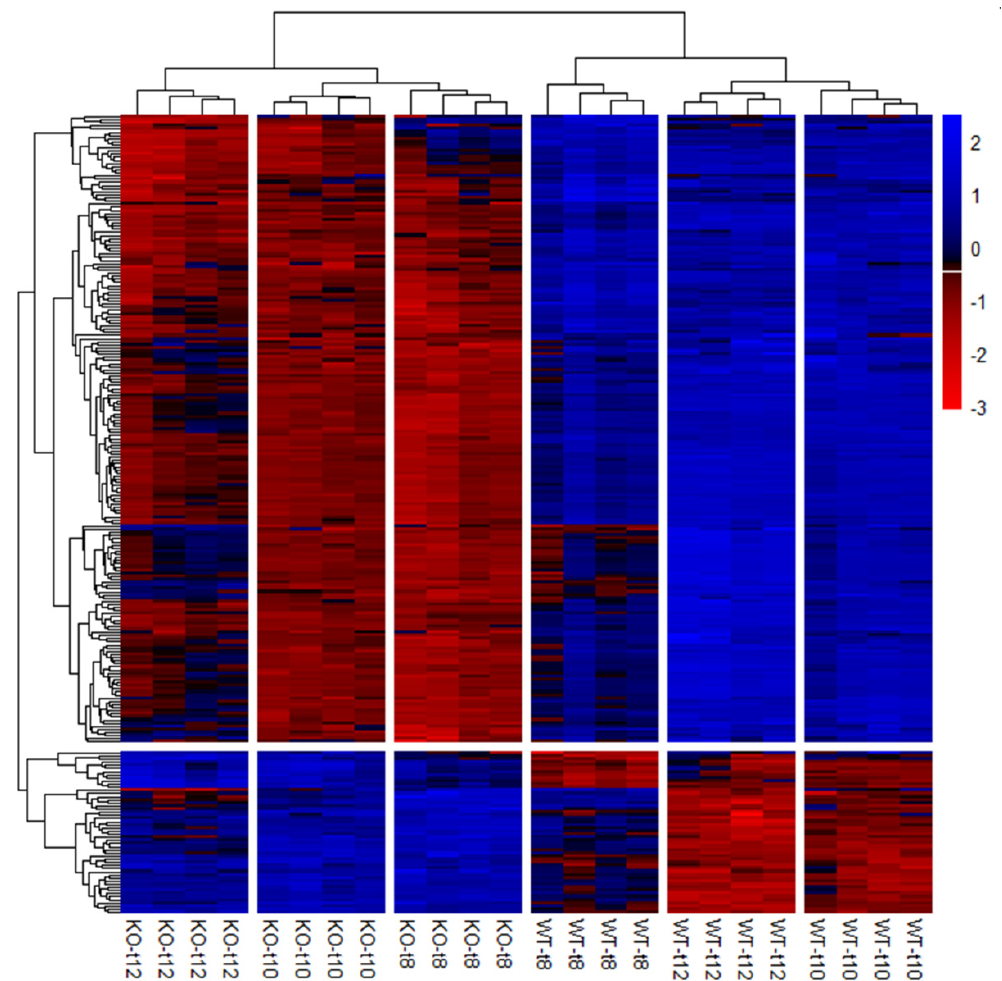
Figure 6. Hierarchical clustering and heat map of the 254 significantly regulated candidate genes. Each column represents a sample of SCCx43KO mice or their WT littermates at different ages ( n = 4 per genotype and age group, t8: 8-day-old, t10: 10-day-old, t12: 12-day-old). Genes are depicted in rows. Red indicates downregulation and blue indicates upregulation. KO: knockout, SCCx43KO: Sertoli cell-specific Cx43 knockout, WT: wild type.